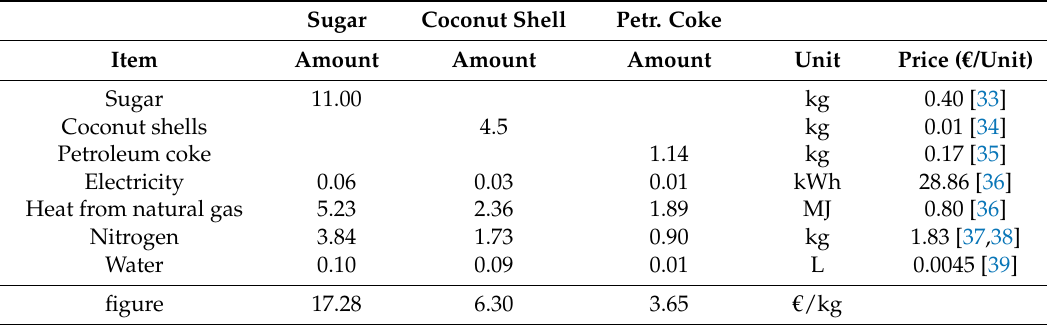
Table 2. Inputs required for the production of 1 kg of hard carbon and final hard carbon